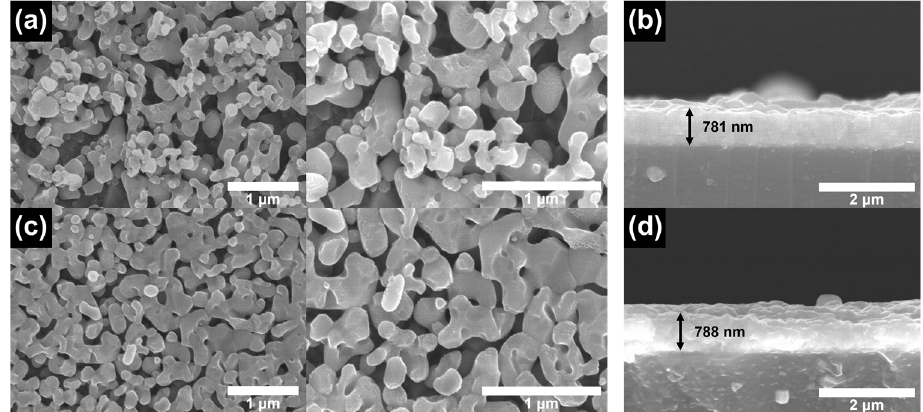
Figure 1. Top and cross-sectional SEM images for ( a , b ) bare BiVO 4 and ( c , d ) BiVO 4 /PbS QDs films on FTO glasses.